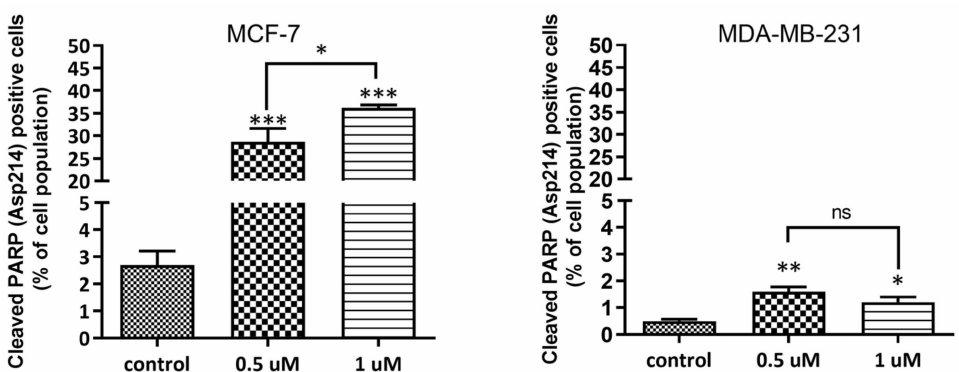
Figure 5. Percentage of the cell population containing cleaved PARP. MCF-7 and MDA-MB-231 cells were exposed to AJ-418 at 0.5 µ M and 1 µ M for 24 h, then labeled with Anti-Cleaved-PARP antibody (Asp214) and analyzed using flow cytometry. Data represent means ± SEM of three independent experiments. Statistical significance was determined using one-way ANOVA and the Student–Newman–Kleus post-hoc multiple comparison test; *** p < 0.001, ** p < 0.01, * p < 0.05 represent statistically significant differences in comparison to controls, ns—no statistical significance.